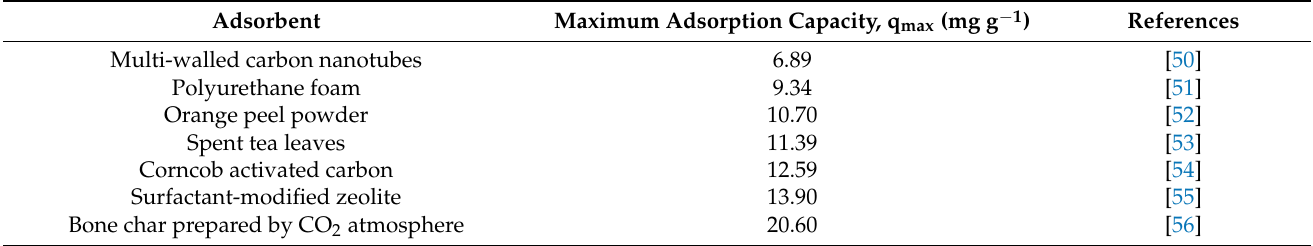
Table 8. Comparison of maximum monolayer adsorption capacity of RBBR dye onto various